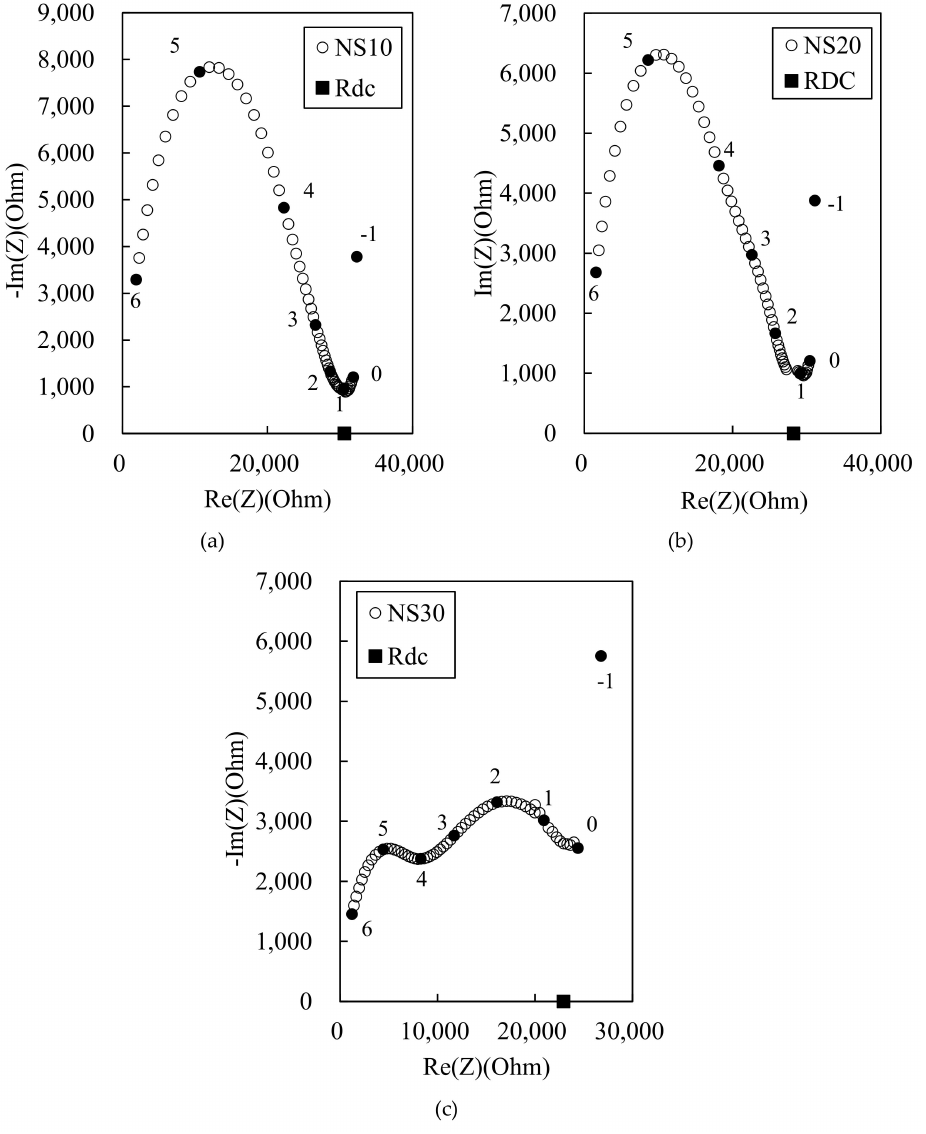
Figure 5. Experimental Nyquist plot for 100 MPa-HPCC with MWCNT solution at ( a ) 10%, ( b ) 20%, and ( c ) 30% replacement of mix